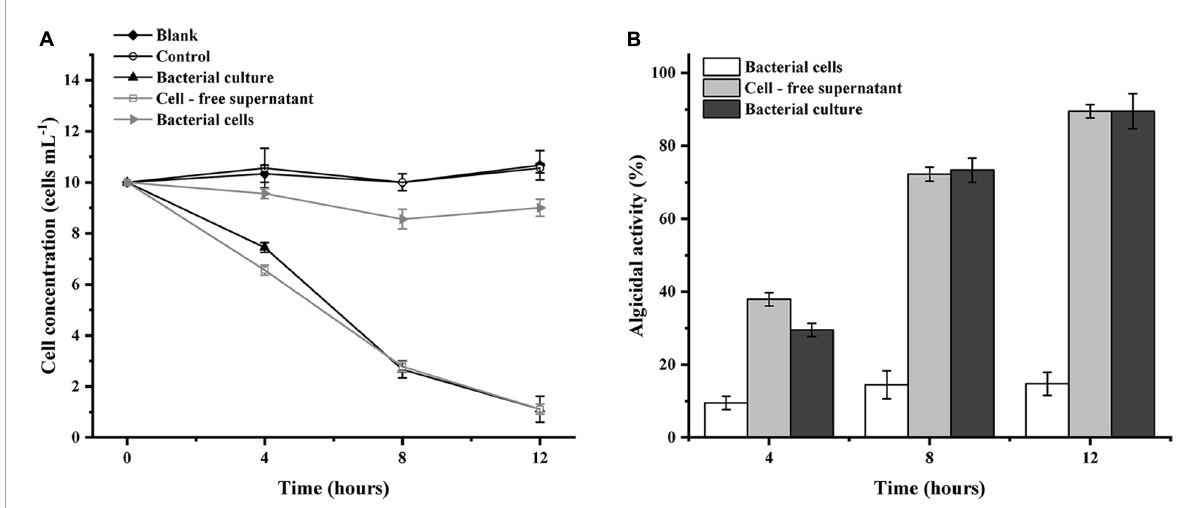
FIGURE5 Algicidal activities of different fractions of LD-B6 culture on Noctiluca scintillans based on (A) algal cell concentration and (B) algicidal activity. The error bars represent standard deviations ( n = 3).